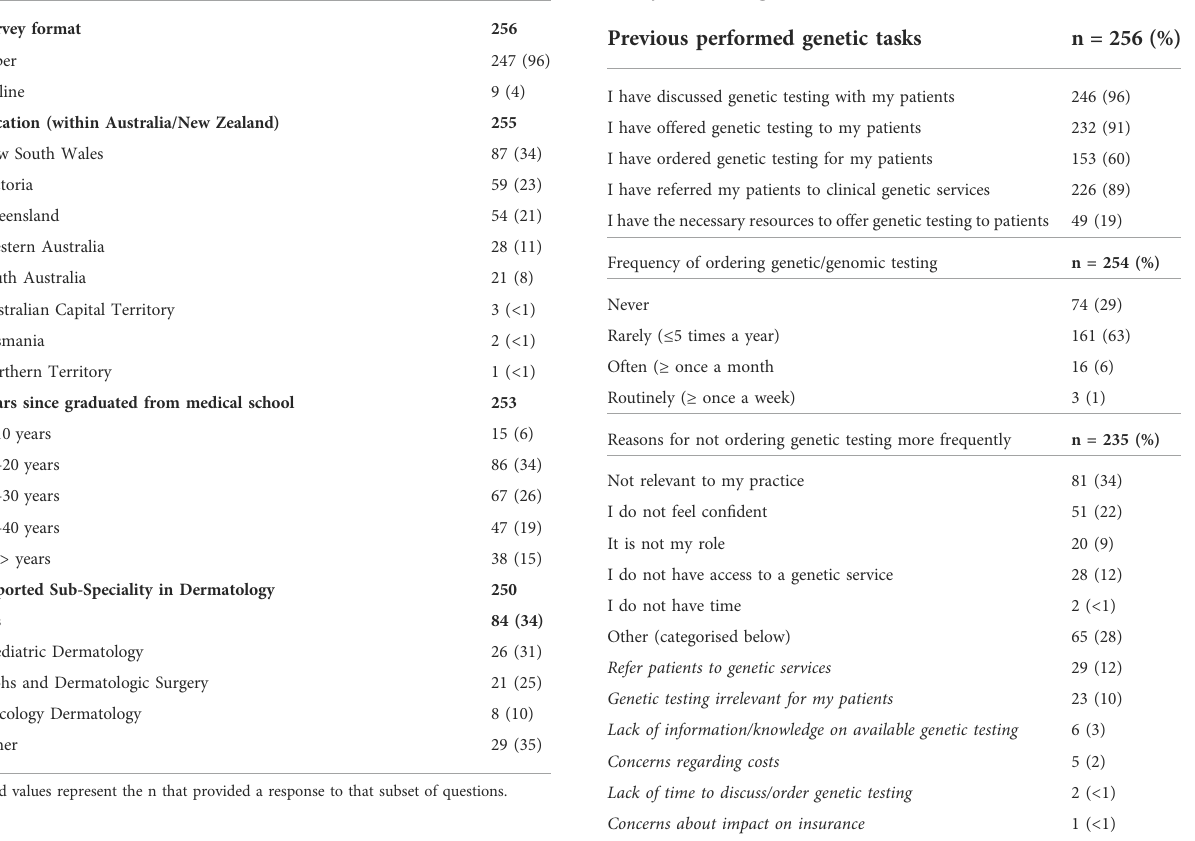
condition, including previously-performed genetic tasks, frequency of ordering genetic/genomic testing, and reasons for infrequent